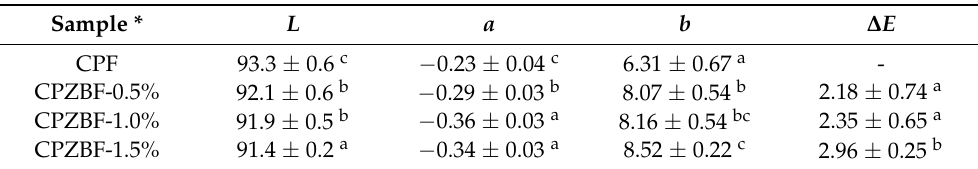
Table 2. Effect of ZnO concentration on the surface color of the crosslinked pectin/ZnO bionanocom- posite films (CPZBF).